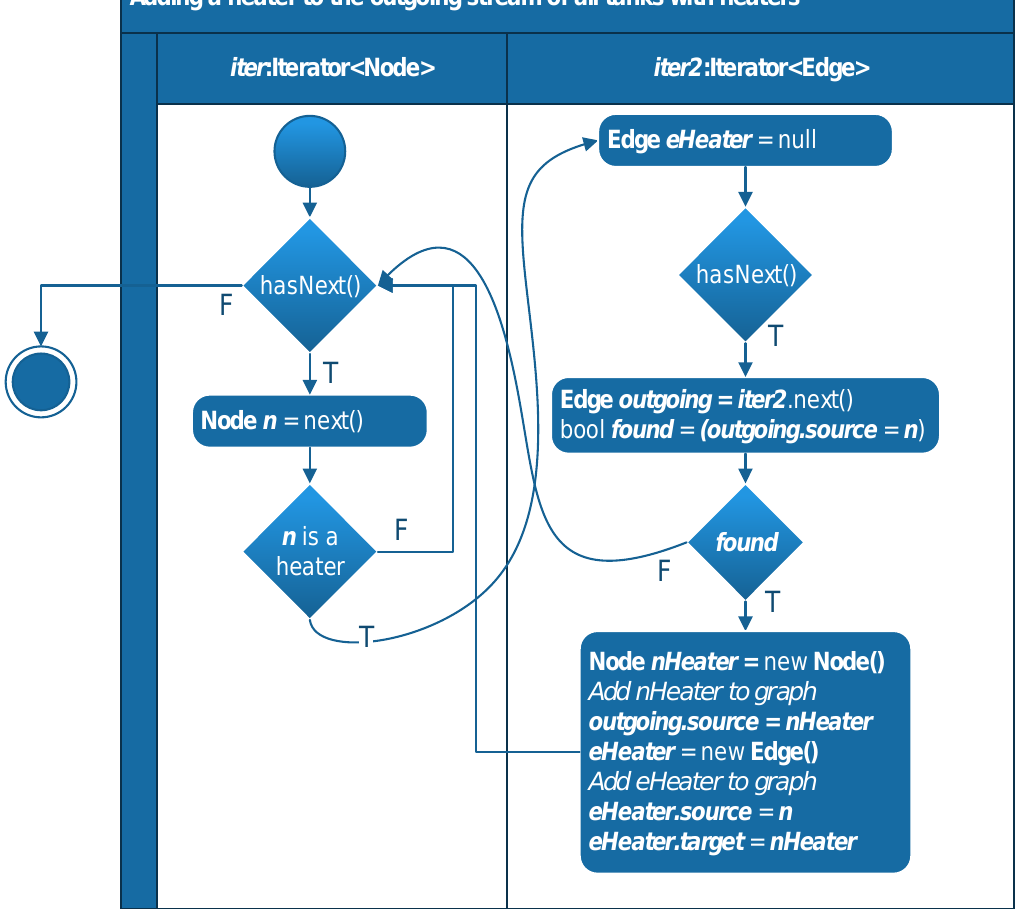
Figure 4. A UML activity diagram representation of an algorithm for manipulating heating elements in the intermediate graph.